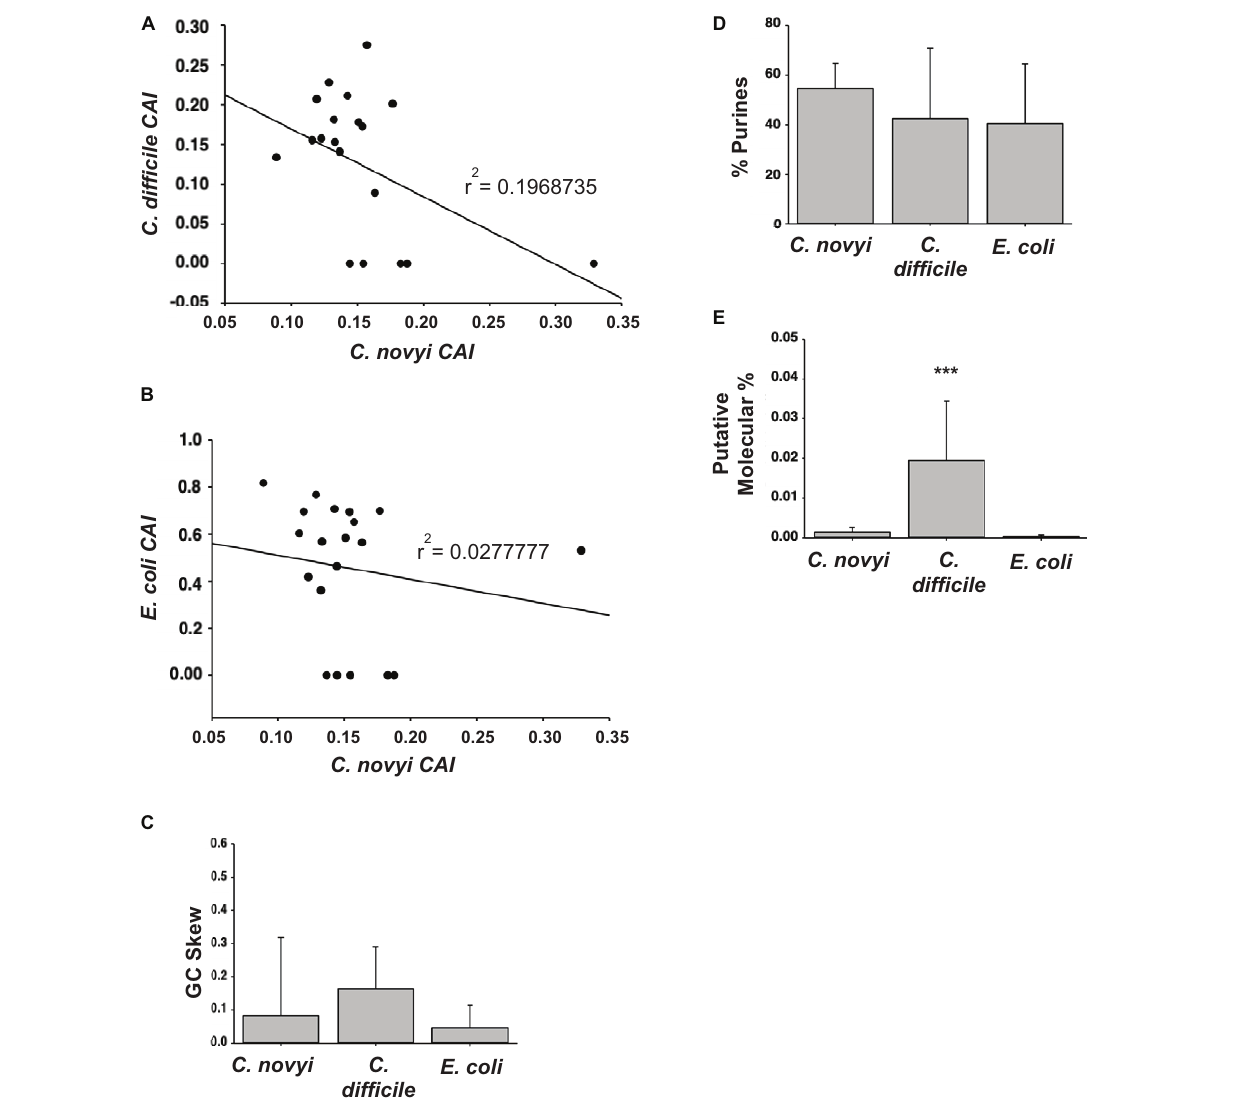
FIGURE 3 | Designing the plasmid. (A,B) The resulting codon adaption index (CAI) values for orthologous genes in C. difficile or E. coli were plotted against those of C. novyi to ascertain a correlation. (C,D) Upon the comparison of the primary sequences of C. novyi genes with the orthologs found in C. difficile and E. colie , the GC skew (C) was determined as was the percent purines for each sequence (D) . (E) The literature was mined for expression data and the putative molecular percent was obtained for each gene and its ortholog. ∗∗∗ indicates a statistical significance of p <